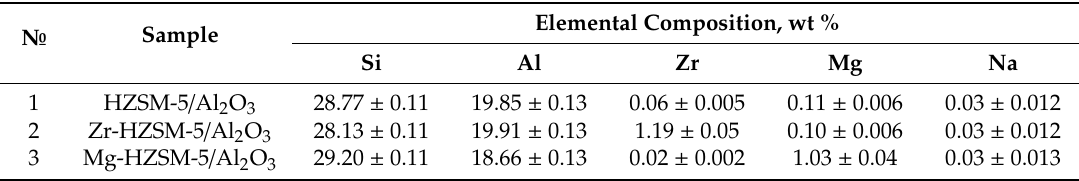
Table 1. Elemental composition for HZSM-5 / Al 2 O 3 material and Zr- and Mg- modified samples.